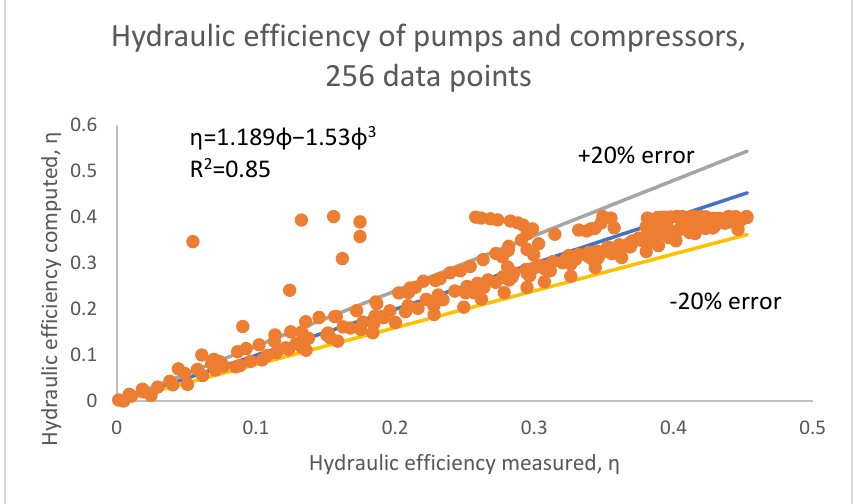
Figure 8. Hydraulic efficiency of double-side vane impeller machines as estimated by the correlation. Equation (23) can be differentiated for the flow coefficient. When the derivative is equated to zero, the condition for maximum efficiency will result as ϕ = 0.51, and the one-side vane impeller